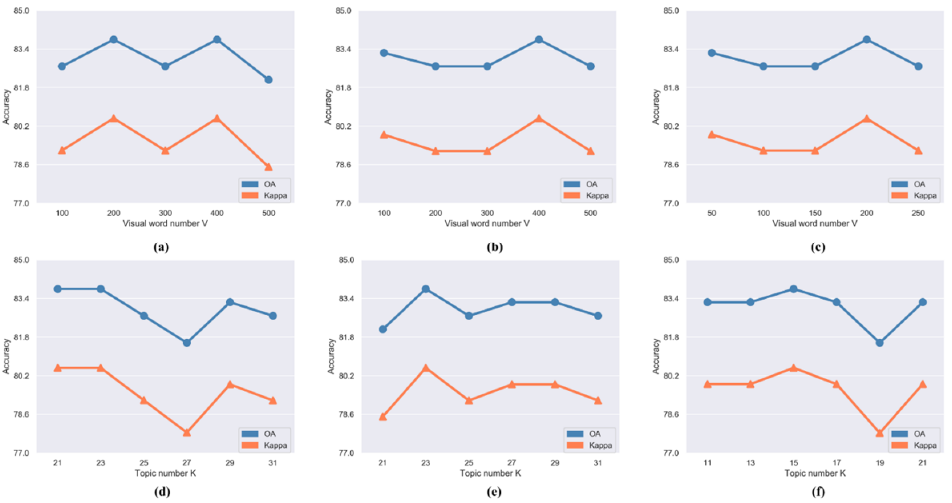
Figure 8. Accuracy assessment ( a – c ) y -axis is the accuracy, x -axis is the visual word number V; ( d – f ) y -axis is the accuracy, x -axis is the topic number K.